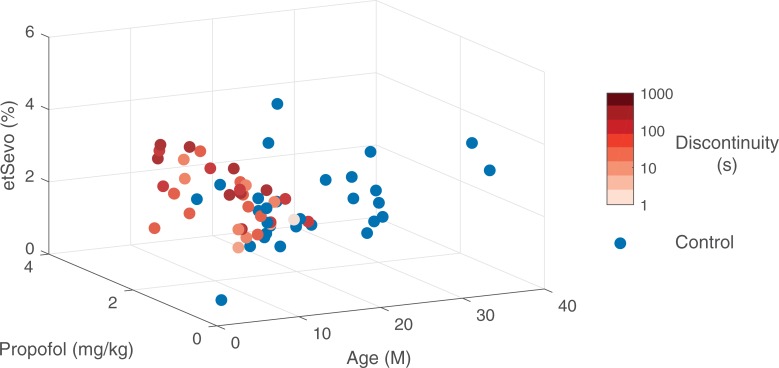
Postnatal age is negatively associated with and anesthetic depth positively associated with discontinuity.Age, median end tidal sevoflurane (etSevo) during induction, and cumulative propofol dose during induction in all subjects (n = 65). A multiple linear regression showed that younger age, increased sevoflurane, and increased propofol were associated with longer cumulative discontinuity during induction (F(4,61) = 6.02, p < .005) with an adjusted R2 of 0.19. Subjects with discontinuity (n = 35) in red (intensity ranges from 1 to 1000 seconds on a log scale) and without discontinuity in blue (n = 30).